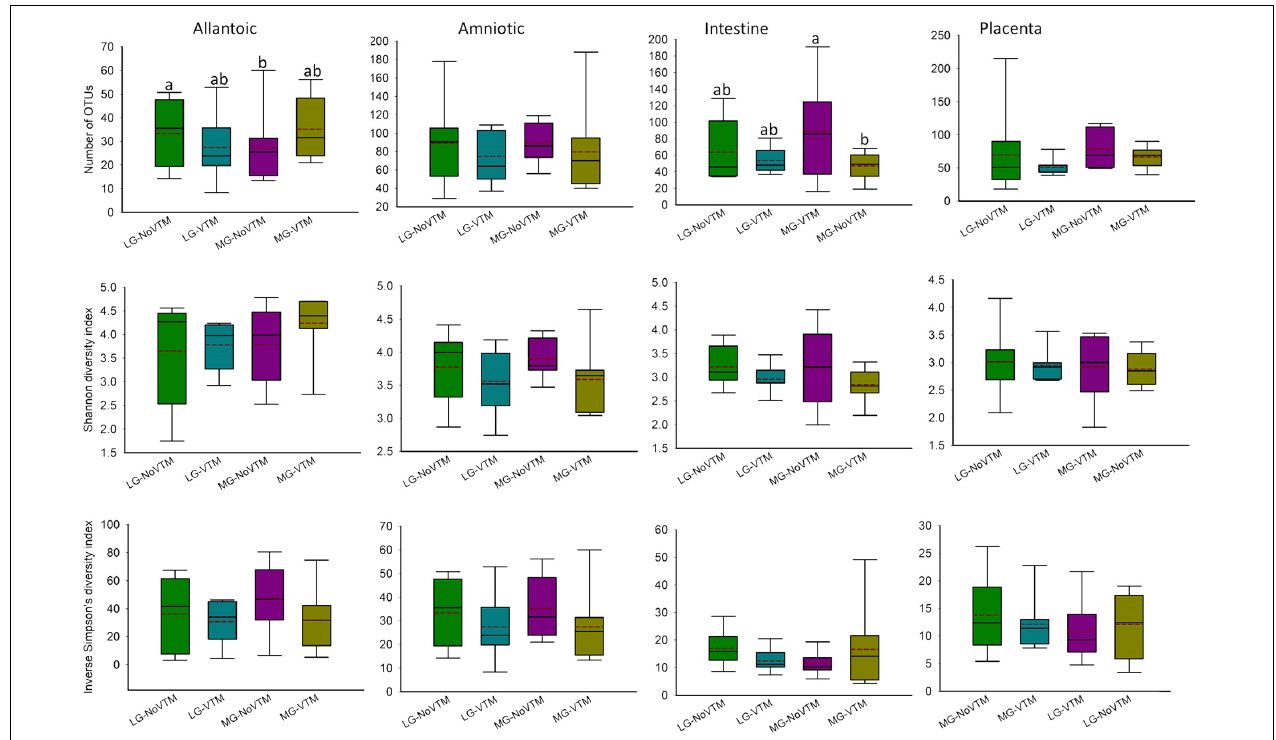
FIGURE 6 | The effects of rate of gain, and vitamin and mineral supplementation on alpha diversity metrics of the allantoic and amniotic fluid, and intestinal and placental microbiota in 84-day-old calf fetuses ( n = 33). The different lowercase letters indicate significantly different means ( P < 0.05). LG-NoVTM, low gain, no vitamin-mineral supplement; LG-VTM, low gain, vitamin-mineral supplement; MG-No VTM, moderate gain, no vitamin-mineral supplement; MG-VTM, moderate gain, vitamin-mineral